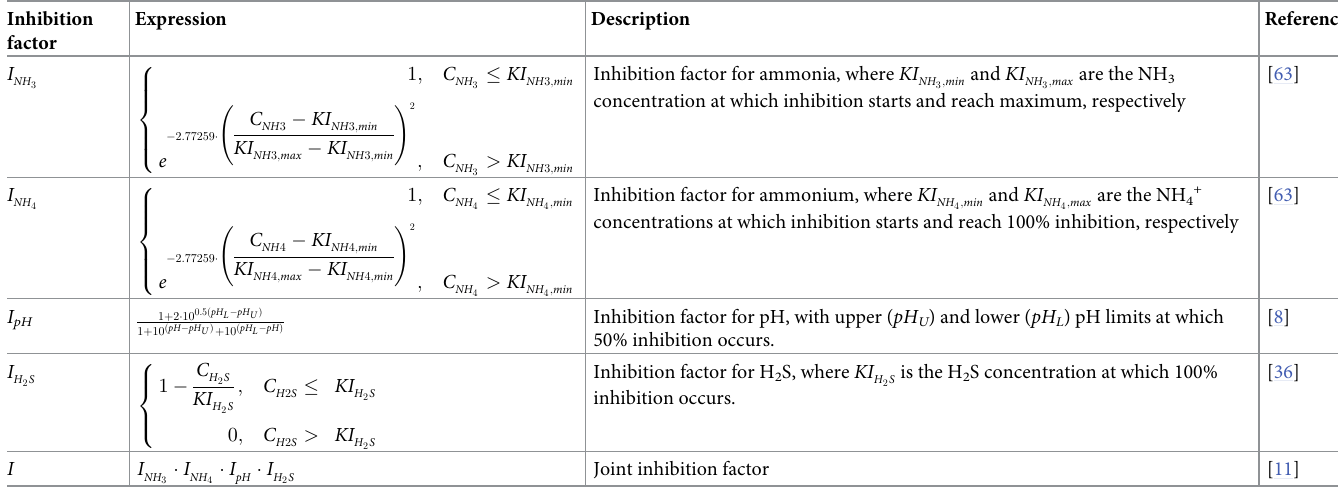
, follows a double Monod expression (Eq sr